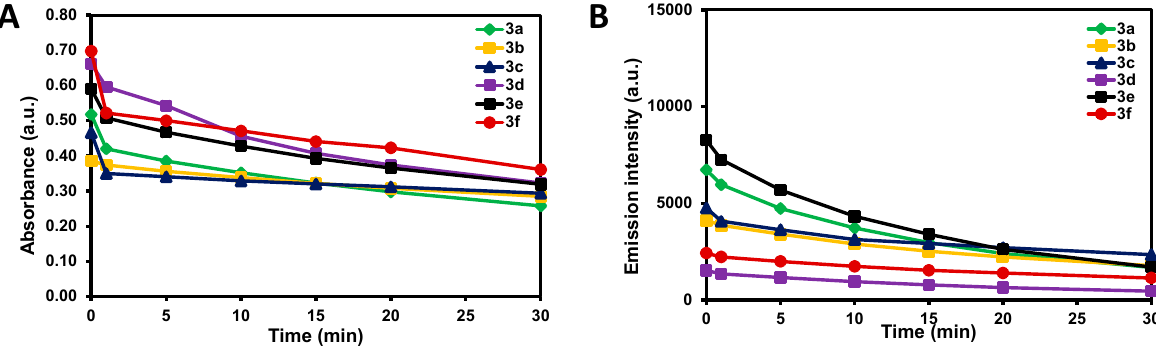
Figure 4. Photobleaching studies at 250 W blue light monitored at the maximum absorbance ( A ) and emission intensity ( B ) of chalcones 3a – f in DMSO.